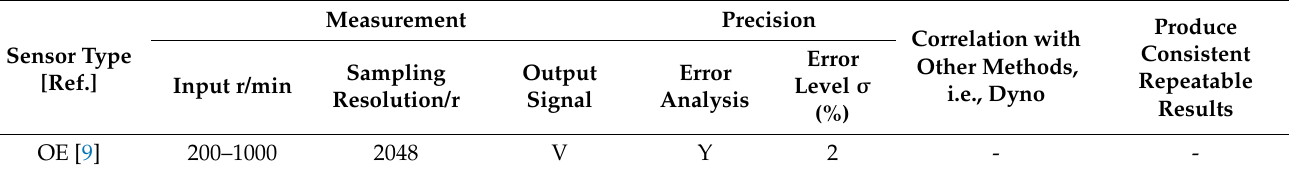
Table 2. Instantaneous angular speed measurement